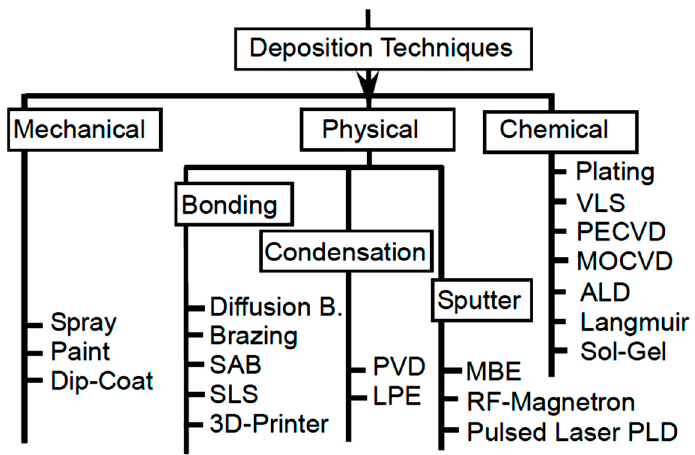
Figure 3. Thin film deposition methods [37].